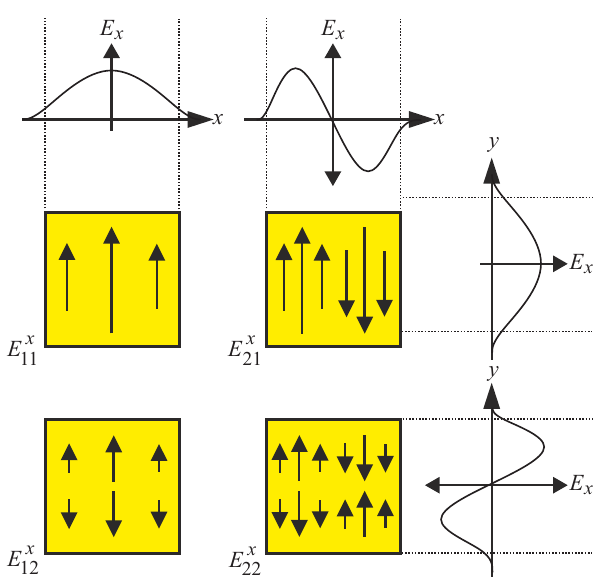
Figure 2. Schematic illustration of the first modes of a quadratic DWG in x-polarization E x mn